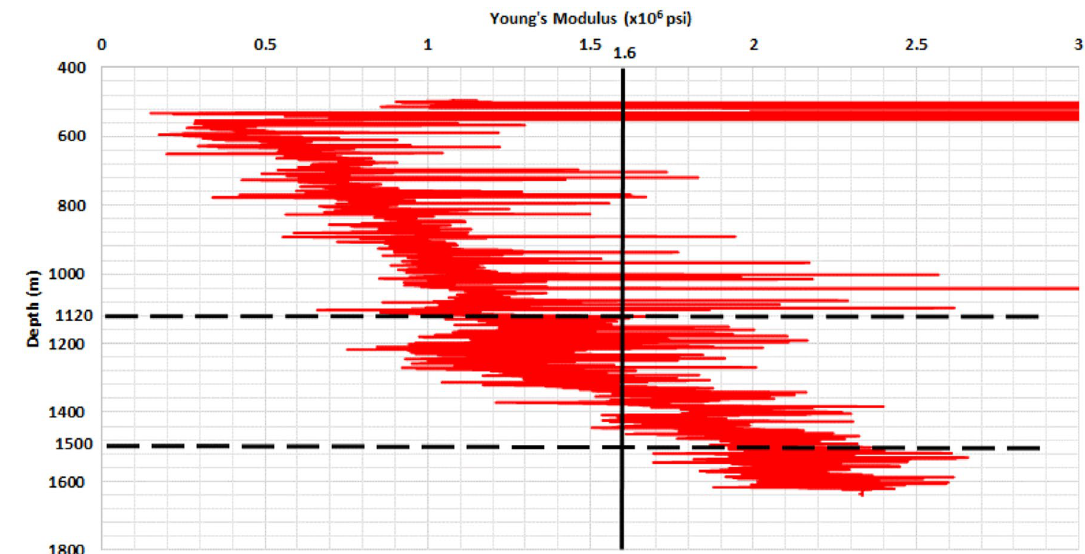
Fig. 17 Young’s modulus of Field X